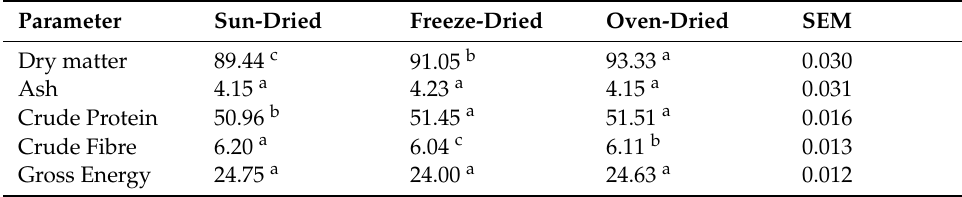
Table 1. Nutrient composition (g/100 g) of dried mealworm larvae. Parameter